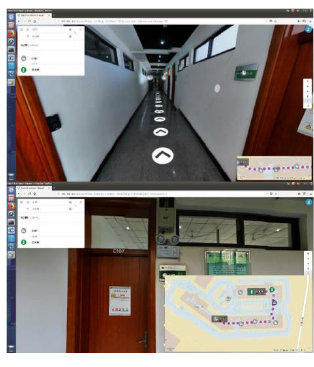
Figure 11. Path planning in Indoor Viewer